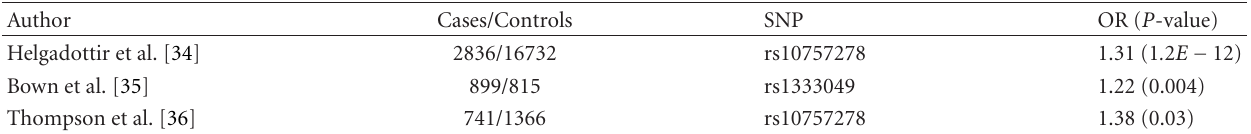
Table 3: Association with SNPs in the 9p21 locus with